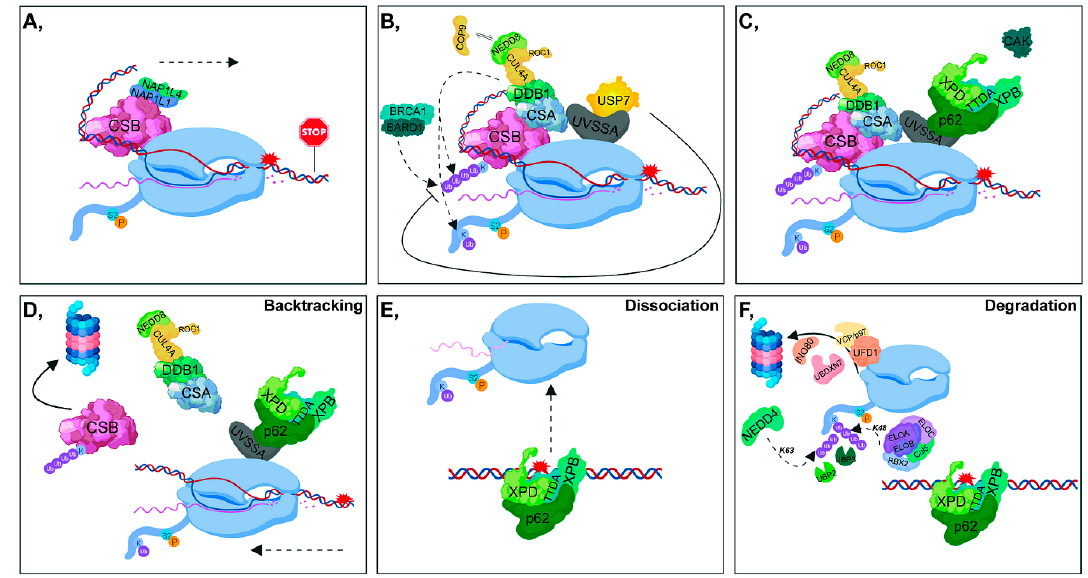
Figure 2. Transcription-coupled-nucleotide excision repair ( A ) Following UV damage, elongating RNAPII (S2P RNAPII) is stalled, then NAP1L1 (Nucleosome assembly protein 1-like 1) as well as NAP1L4 (Nucleosome assembly protein 1-like 4) bind to CSB (Cockayne syndrome B protein). This contributes to the unwinding of the DNA and the forward translocation of RNAPII (indicated with a dashed arrow). ( B ) CRL4 CSA (composed of CUL4A, ROC1 - RING-box protein 1/RING subunit of SCF